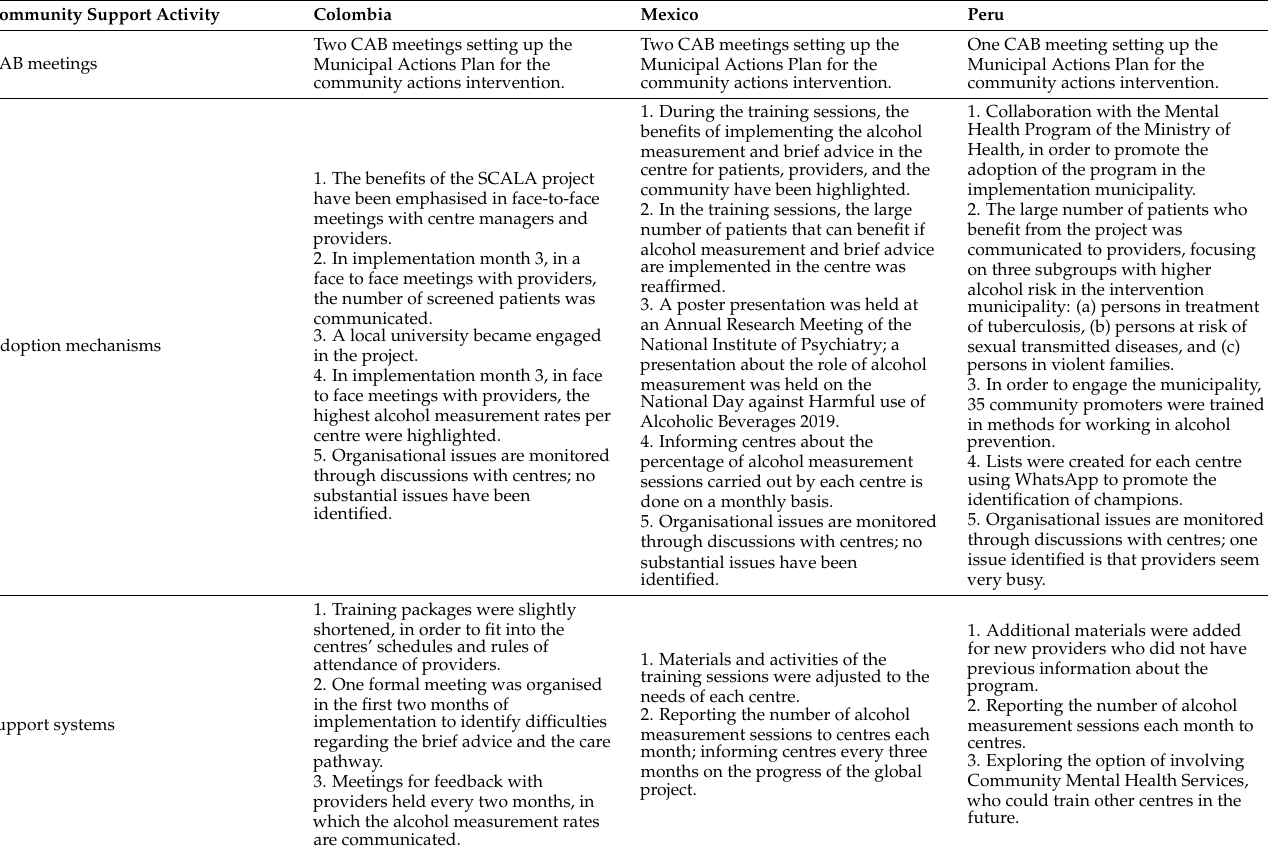
Table A3. SCALA community support implemented in the three intervention municipalities until end of implementation, month